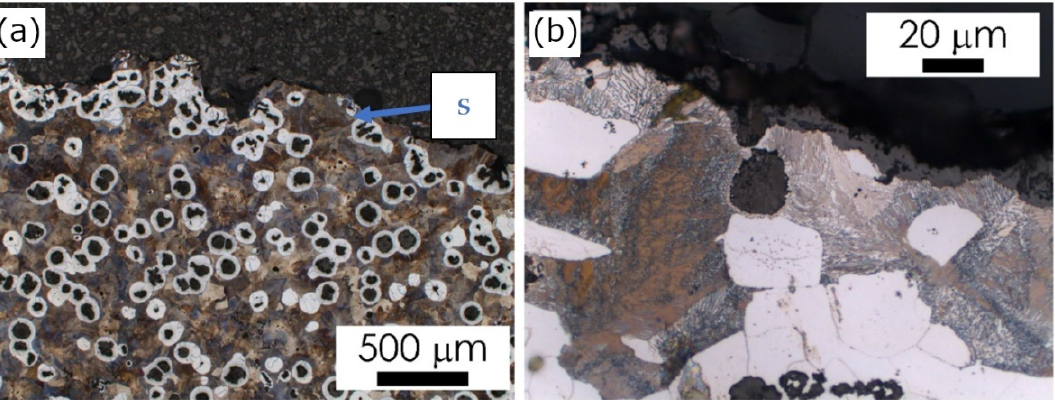
Figure 6. Casting No. 3, prepared in alkyd molding sand No. 3, LM etched with 4% Nital; ( a ) microstructure of alloy, microscope magnification 100 × , ( b ) microstructure of the superficial zone (S), microscope magnification 1000 ×.